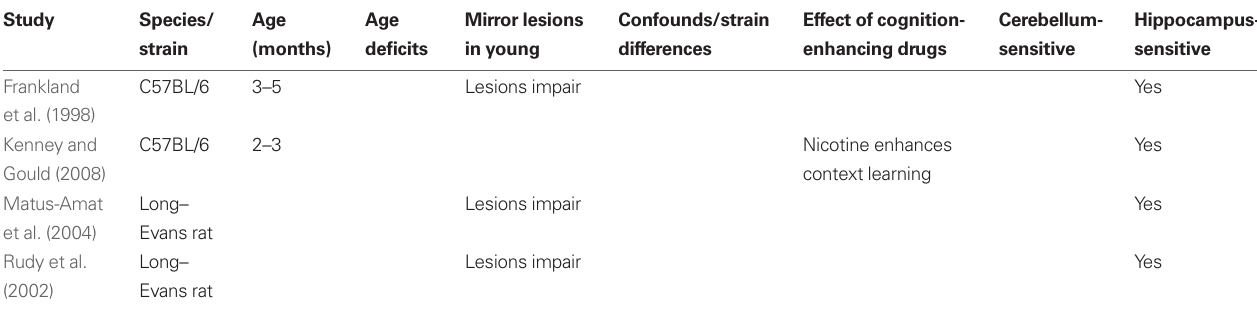
Table 6 | Context pre-exposure facilitation effect: age